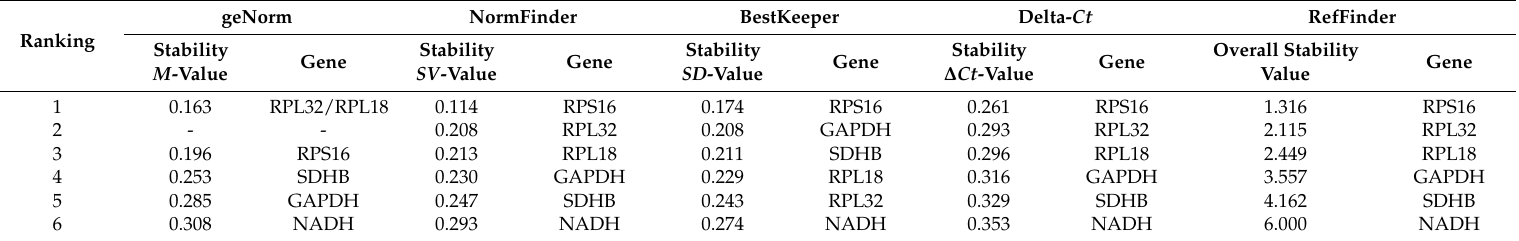
Table 5. Ranking of candidate reference genes according to stability values evaluated in development stages of A. sexdens. geNorm NormFinder BestKeeper Delta- Ranking